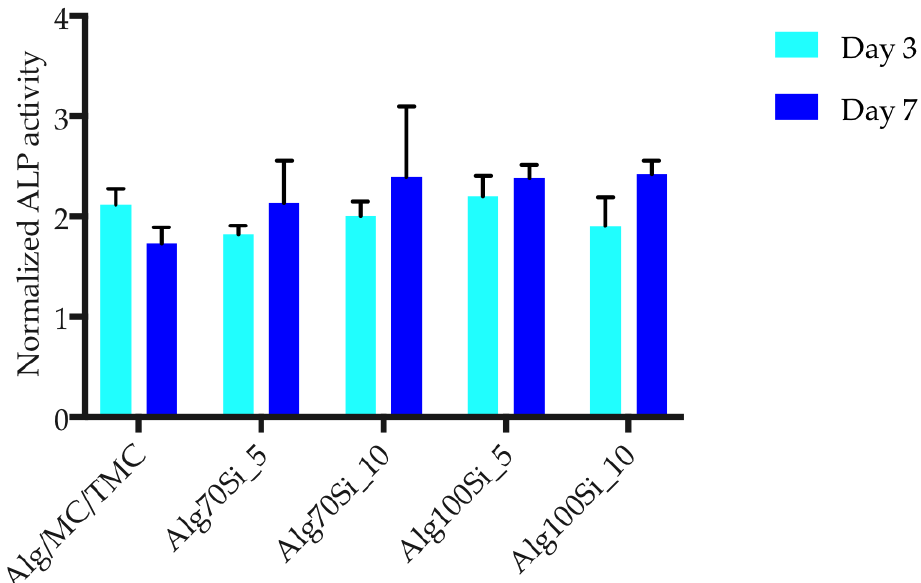
Figure 9. Alkaline phosphatase activity of MC3T3-E1 pre-osteoblastic cells on the five scaffold compositions after 3 and 7 days in culture. The values represent means ± standard deviations of triplicates ( n = 3). Statistical analysis revealed no significant differences among the five scaffold compositions at each time point.